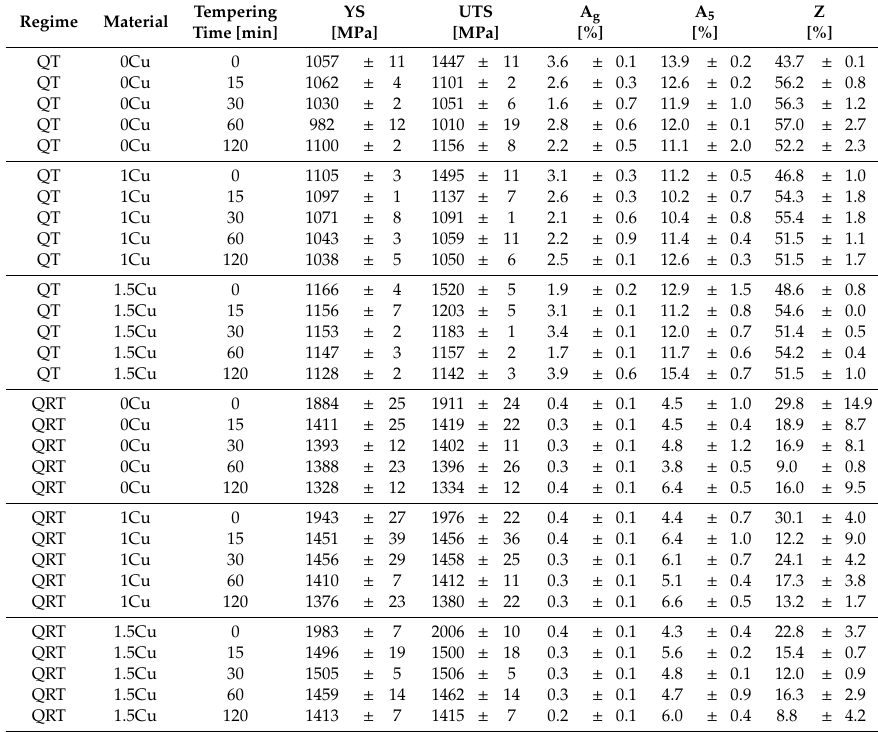
Table A1. Tensile test results for the tempering at 400 ◦ C. Values of QT samples were taken from [11].